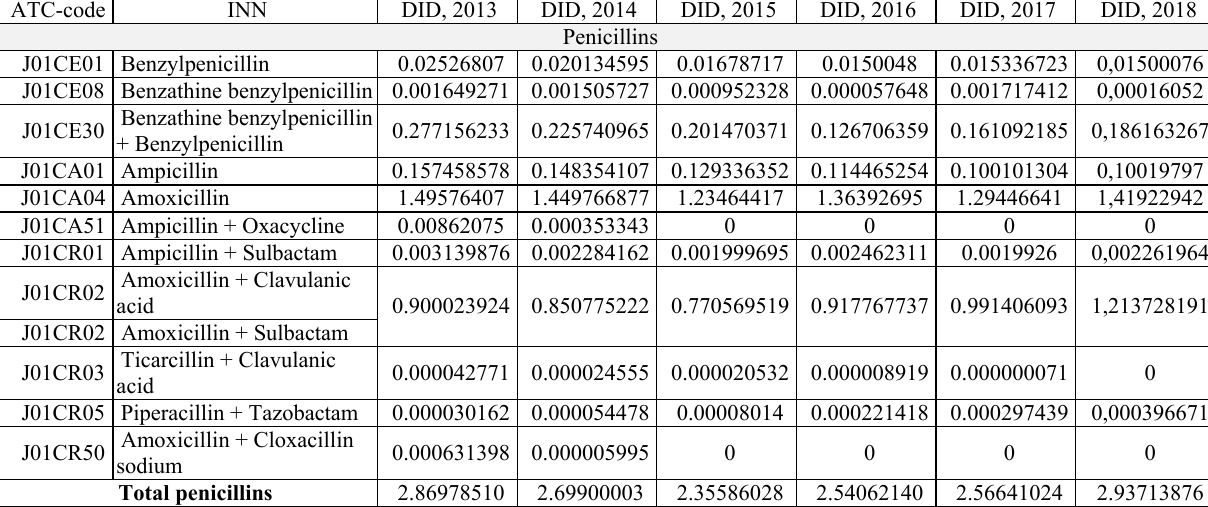
Consumption of AMI of β -lactam group from 2013 to 2018 in